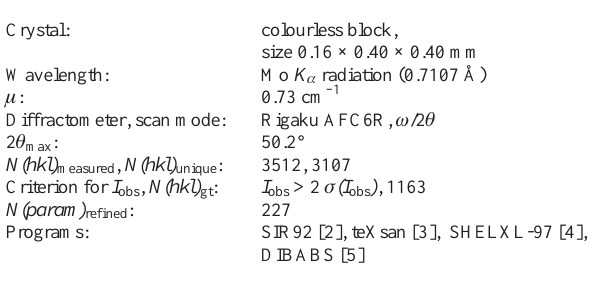
Table 1. Data collection and handling.